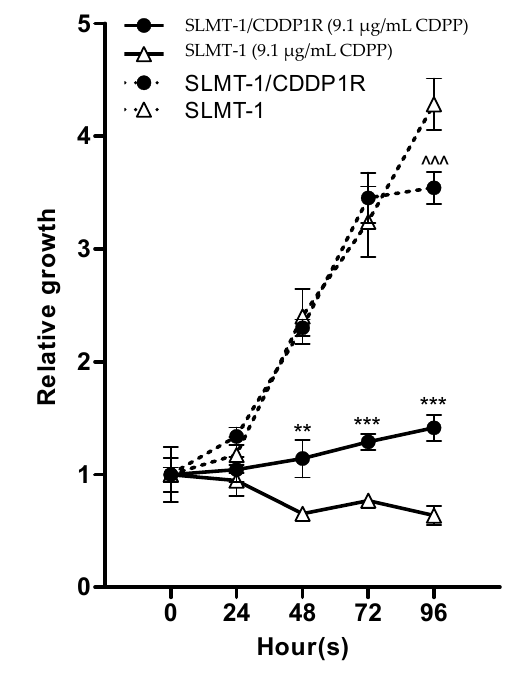
Figure 1. Evaluation for cisplatin-resistance. ( A ) Relative mitochondrial (MTS) activities of SLMT-1 and SLMT-1/CDDP1R cells after 48 h treatment with cisplatin (CDDP) at different concentrations (0, 1.25, 2.5, 5, 10, 20 and 40 μ g/mL). Relative MTS activities were expressed as means ± standard error